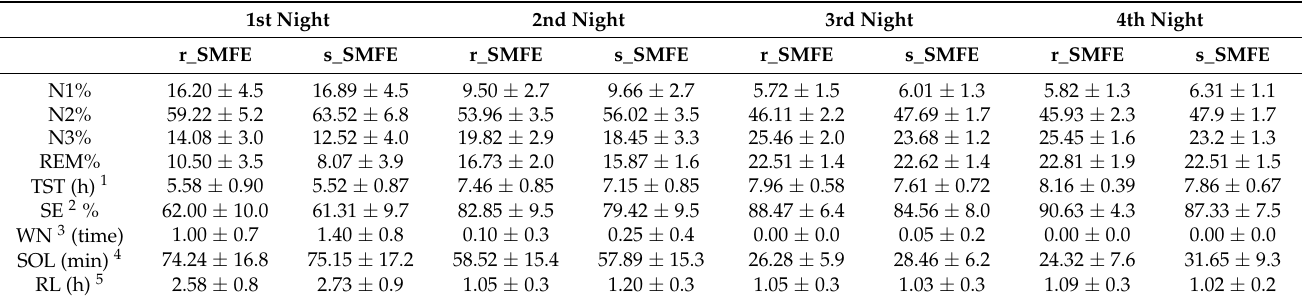
Table 3. Results of EEG (mean ± SD).